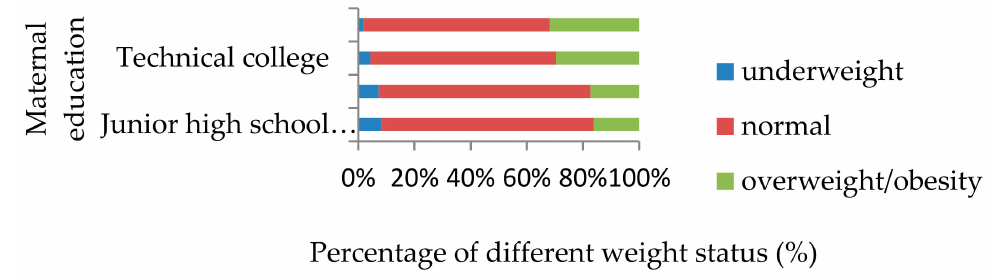
Figure 1. Children weight status distribution of di ff erent maternal education